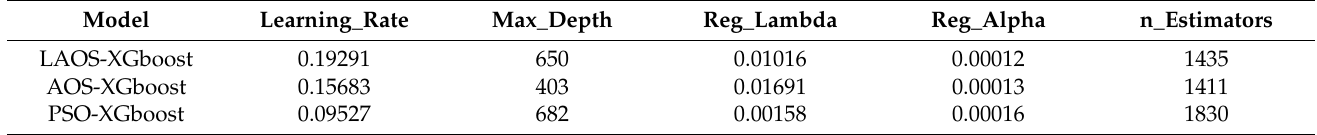
Table 1. Super parameter table of optimization results of each model.